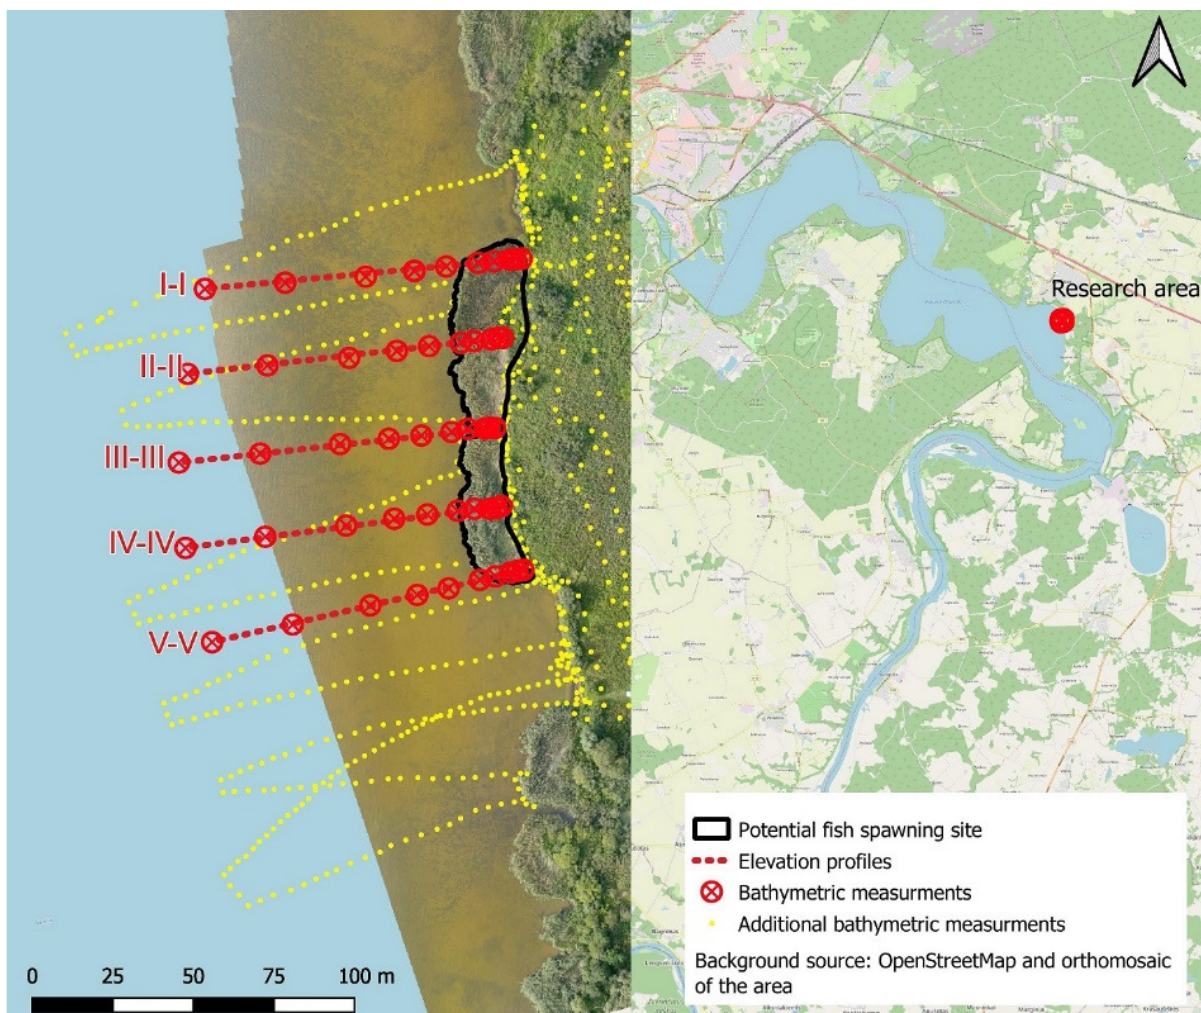
Figure 2. Map of the research area.